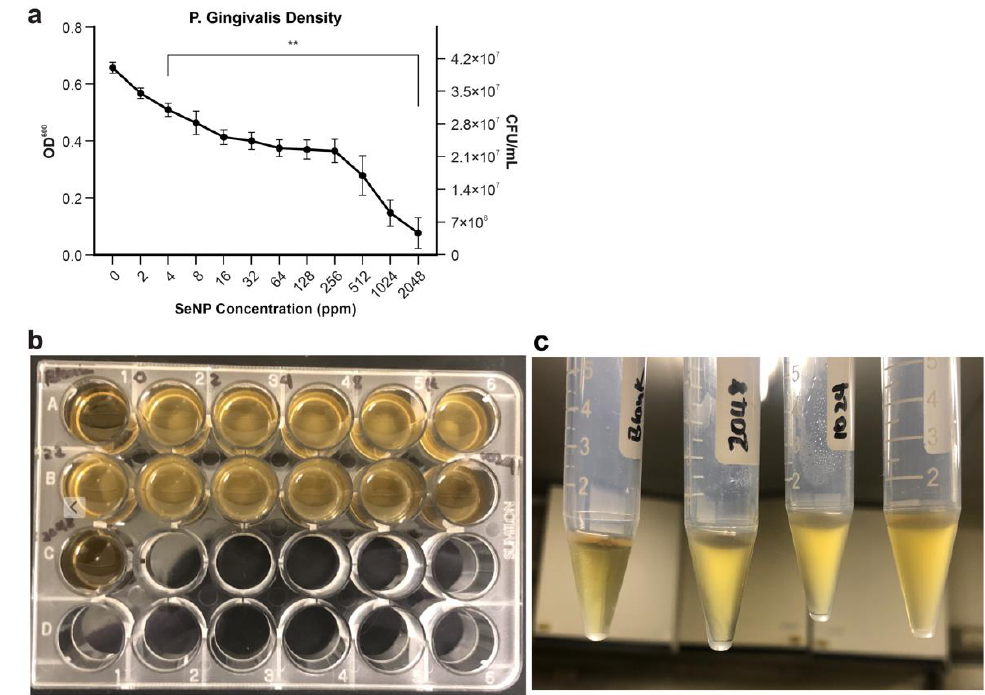
Figure 5. Effect of selenium nanoparticle (SeNP) concentration on P. gingivalis growth. SeNPs were added to P. gingivalis solution, and the resultant solution was incubated for 96 h before examination. ( a ) Standard curve of optical density at 600 nm (OD600) was used to extrapolate the colony forming units per millimeter (CFU/mL) data. Data are expressed as mean ± standard deviation, n = 3. (*: p < 0.05, **: p < 0.01). ( b ) Minimal bactericidal concentration of SeNP on P. gingivalis (OD: 0.15). Blank without P. gingivalis (Well A1). P. gingivalis without SeNP (Well A2). SeNP concentration of 2048 (Well C1) showing slight evidence of bacteria with close similarity in transparency to blank. ( c ) Transparency of blank in comparison to SeNP concentrations.